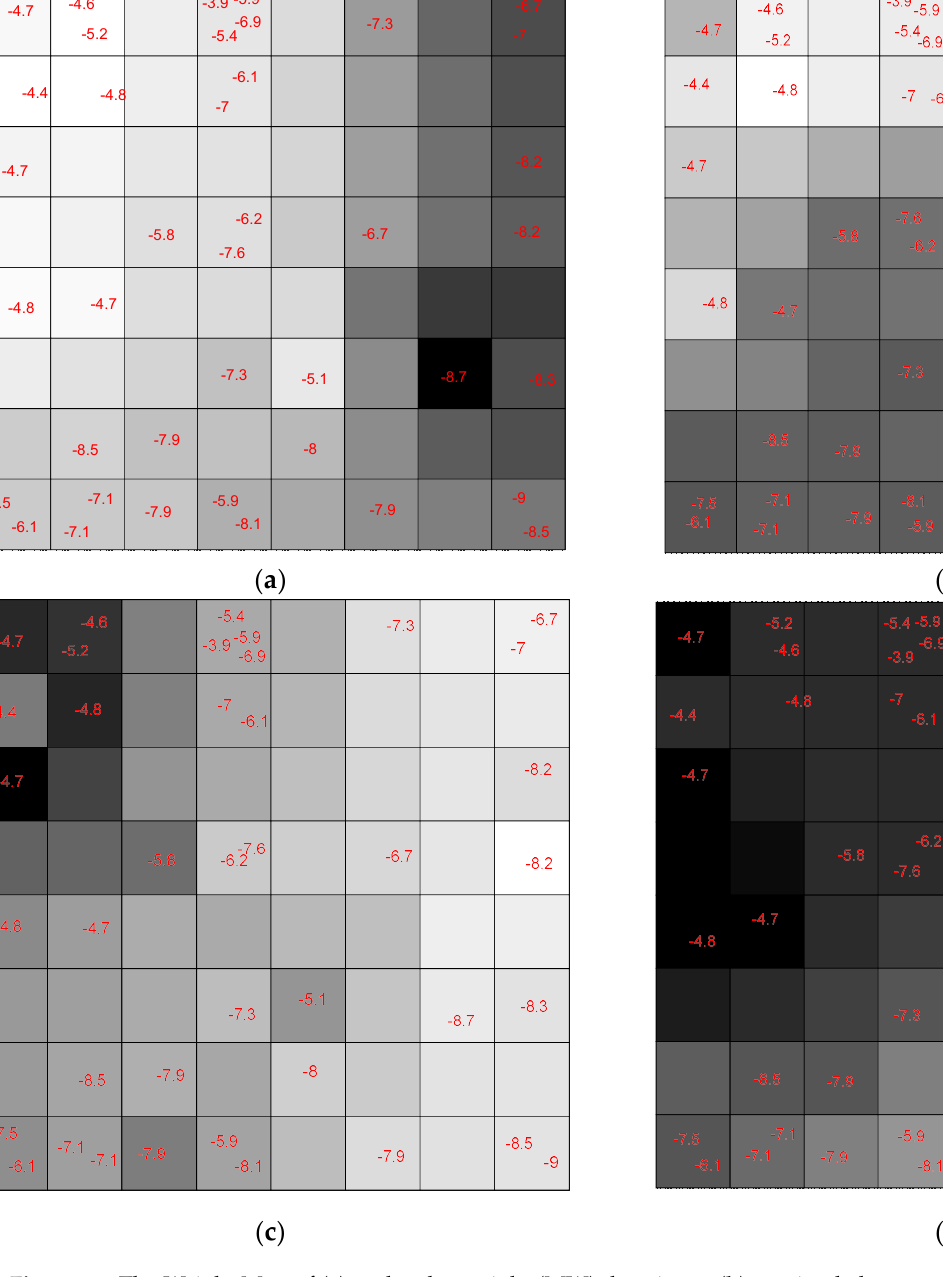
Figure 22. The Weight Map of ( a ) molecular weight (MW) descriptor; ( b ) maximal electrotopological positive variation (MAXDP) descriptor; ( c ) 1st component symmetry directional WHIM index weighted by Sanderson electronegativity